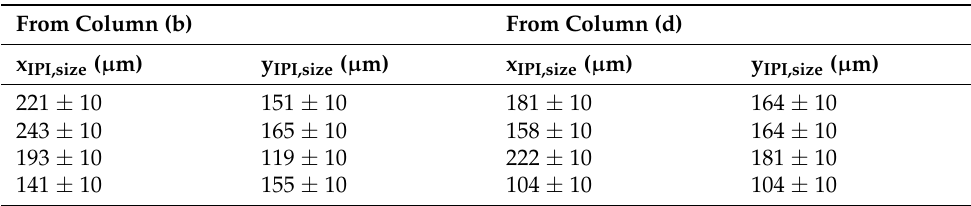
Table 1. Ice particle size measurements obtained from the 2DFT of the speckle-like IPI patterns with measurement uncertainties, from columns (b) and (d) of Figure 3.